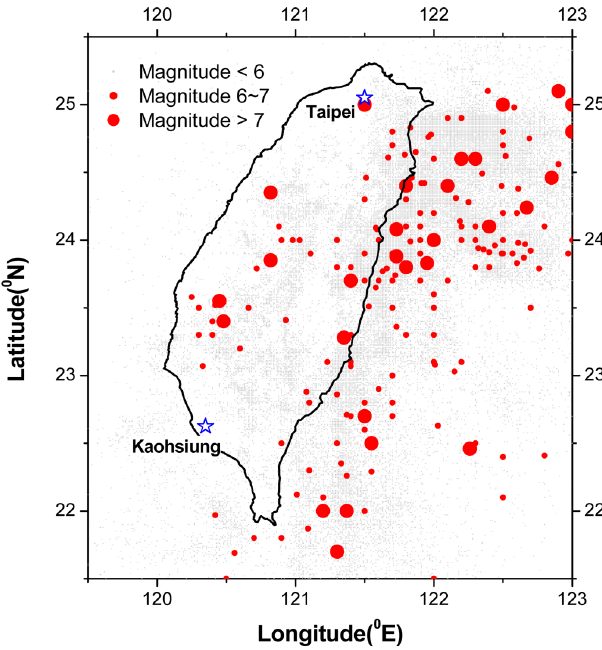
Fig. 4. The seismicity around Taiwan since 1900, based on a catalog containing around 57000